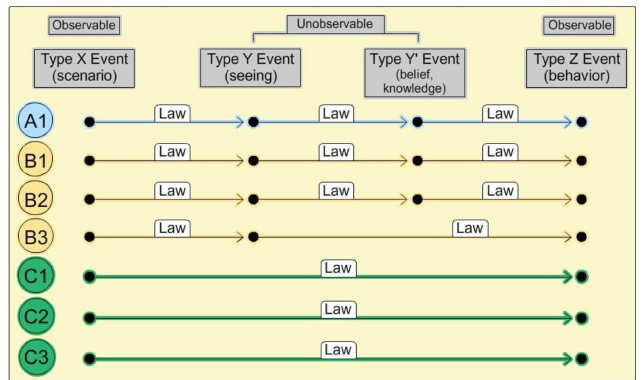
Figure 6. Levels of analysis for each